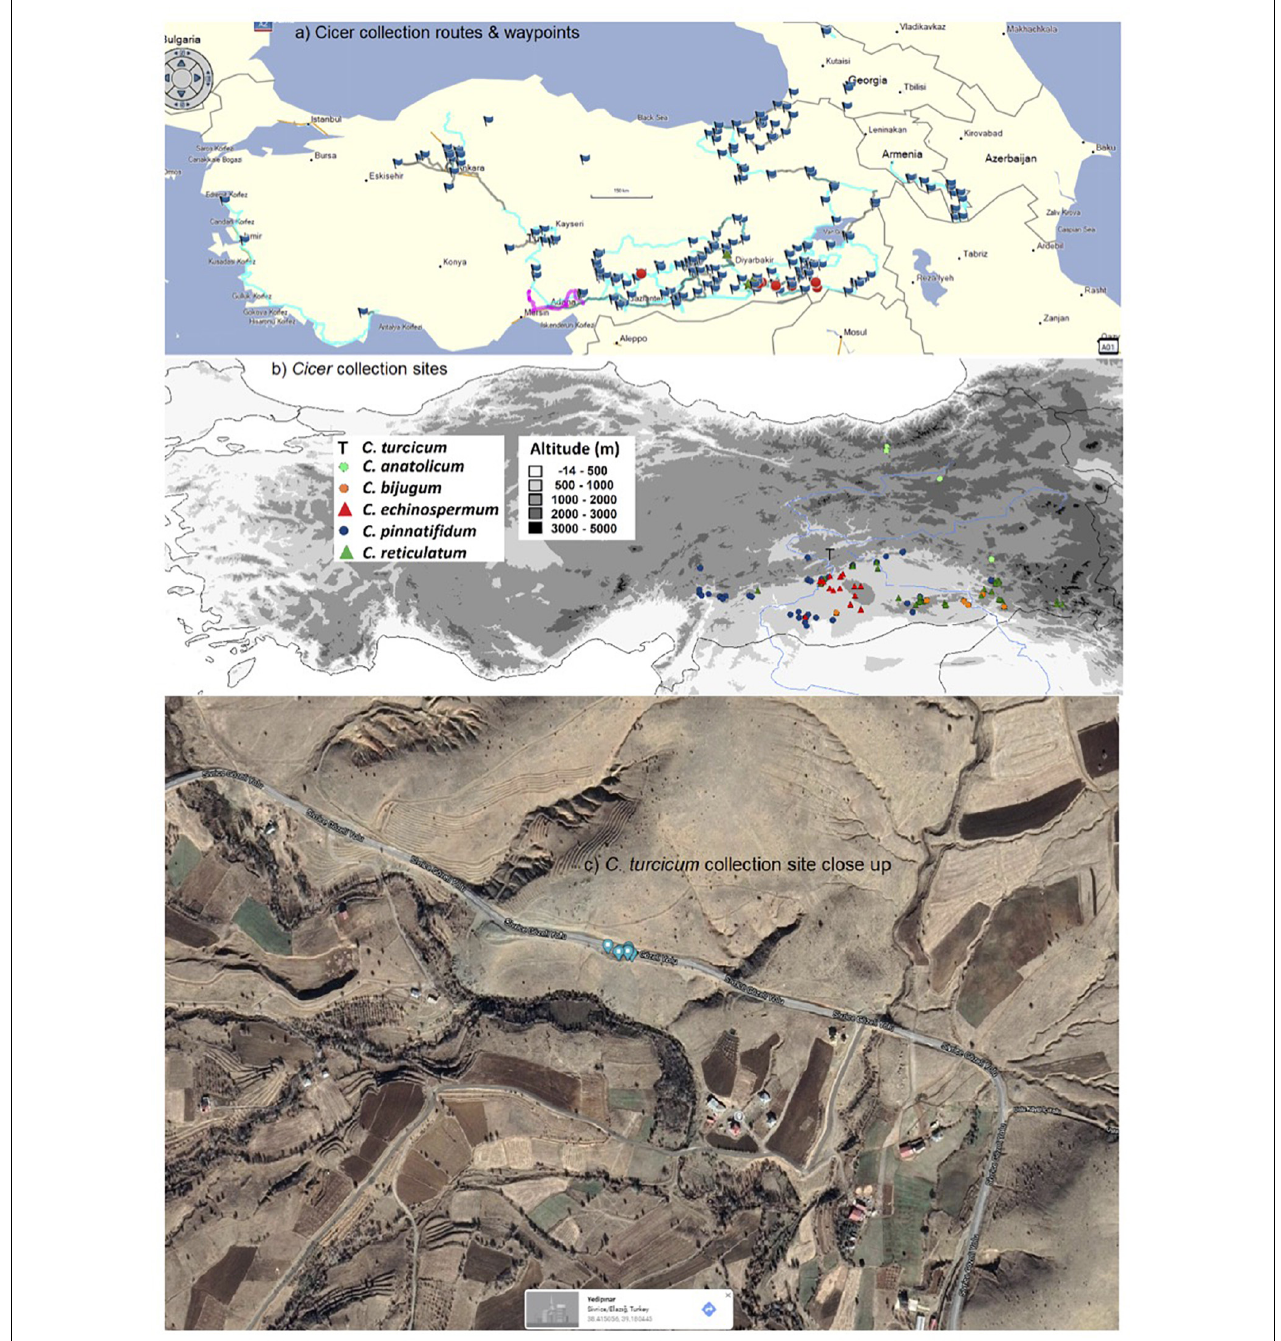
FIGURE 1 | West Asian Cicer survey (2013–18) routes and waypoints (a) , collection sites classified by species (b) , and close-up of the sole C. turcicum collection site at Yedipinar collection site, Sivrice district, Elazig province, Turkey. (Image from Google maps, Map data @2021, Australia) (c)